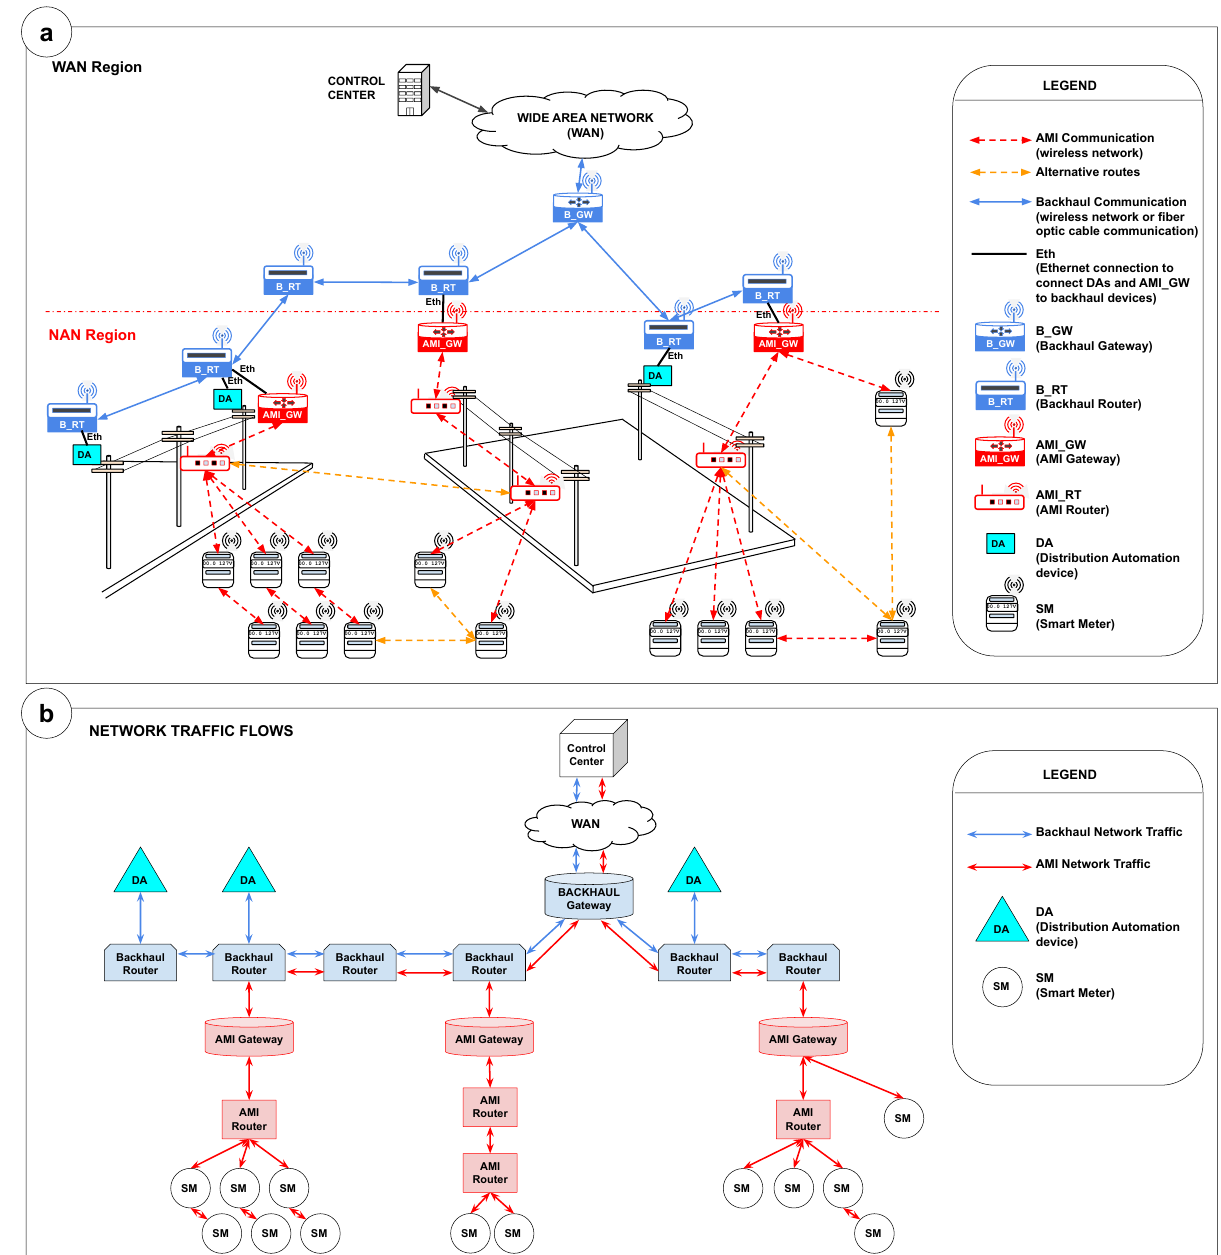
Figure 1. Smart grid scenario. ( a ) Overview of a smart grid scenario, highlighting the main elements in the NAN and WAN regions considered in this research. ( b ) Diagram of Backhaul and AMI network traffic flows to demonstrate the main elements in transferring information between endpoint devices and the control